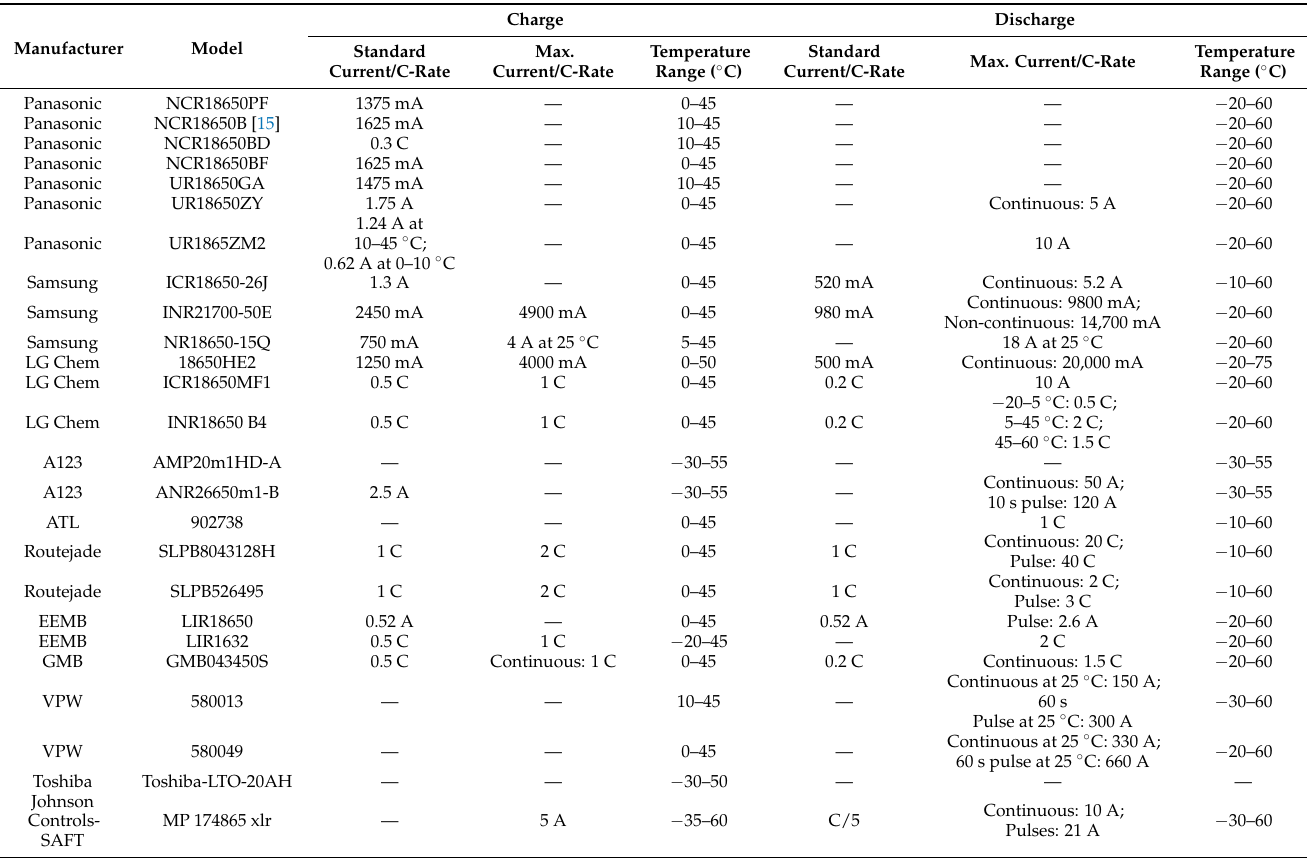
Table 3. Charge and discharge parameters and